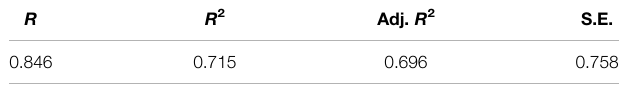
TABLE 10 | Multiple regression model summary.